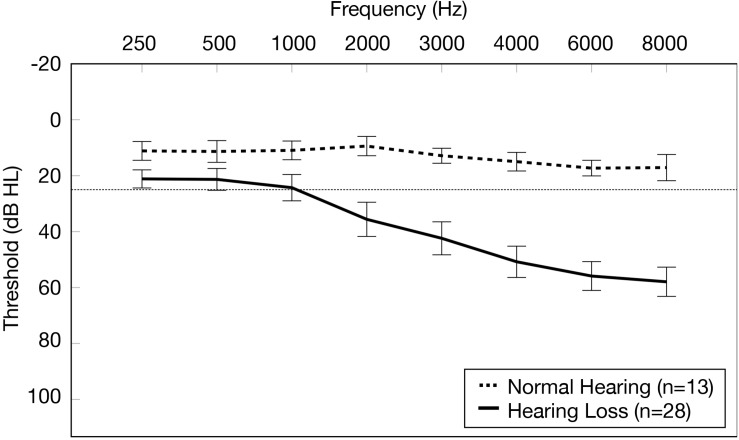
Average pure tone air conduction thresholds for the normal hearing group and age-related hearing loss group. Average pure tone air conduction thresholds across the two ears (0.25–8.0 kHz) are displayed for the normal hearing group (n = 13) (dashed line) and the group with mild-moderate age-related hearing loss (n = 28) (solid line). Frequency (Hz) is displayed on the horizontal axis and pure tone air conduction thresholds in decibels hearing level (dB HL) are displayed on the vertical axis. The dotted line on the y-axis indicates the clinical cutoff for normal hearing thresholds (25 dB HL). The bars display 95% confidence intervals at each threshold for each group.